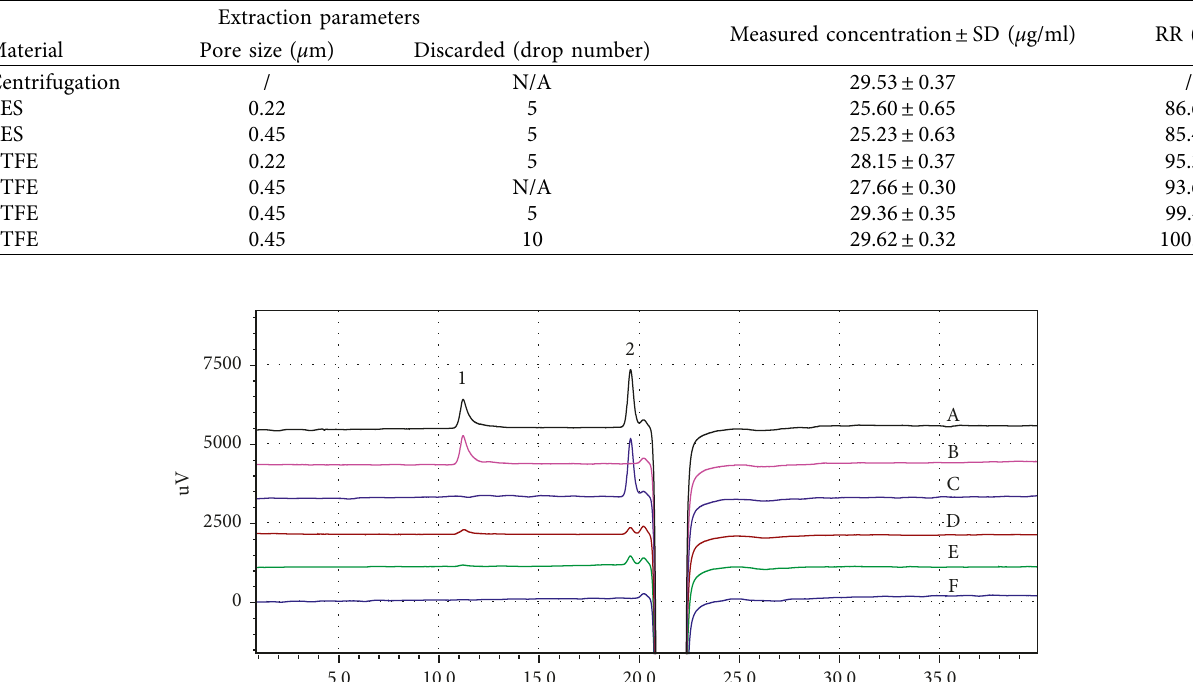
Table 2: The results of membrane adsorption.